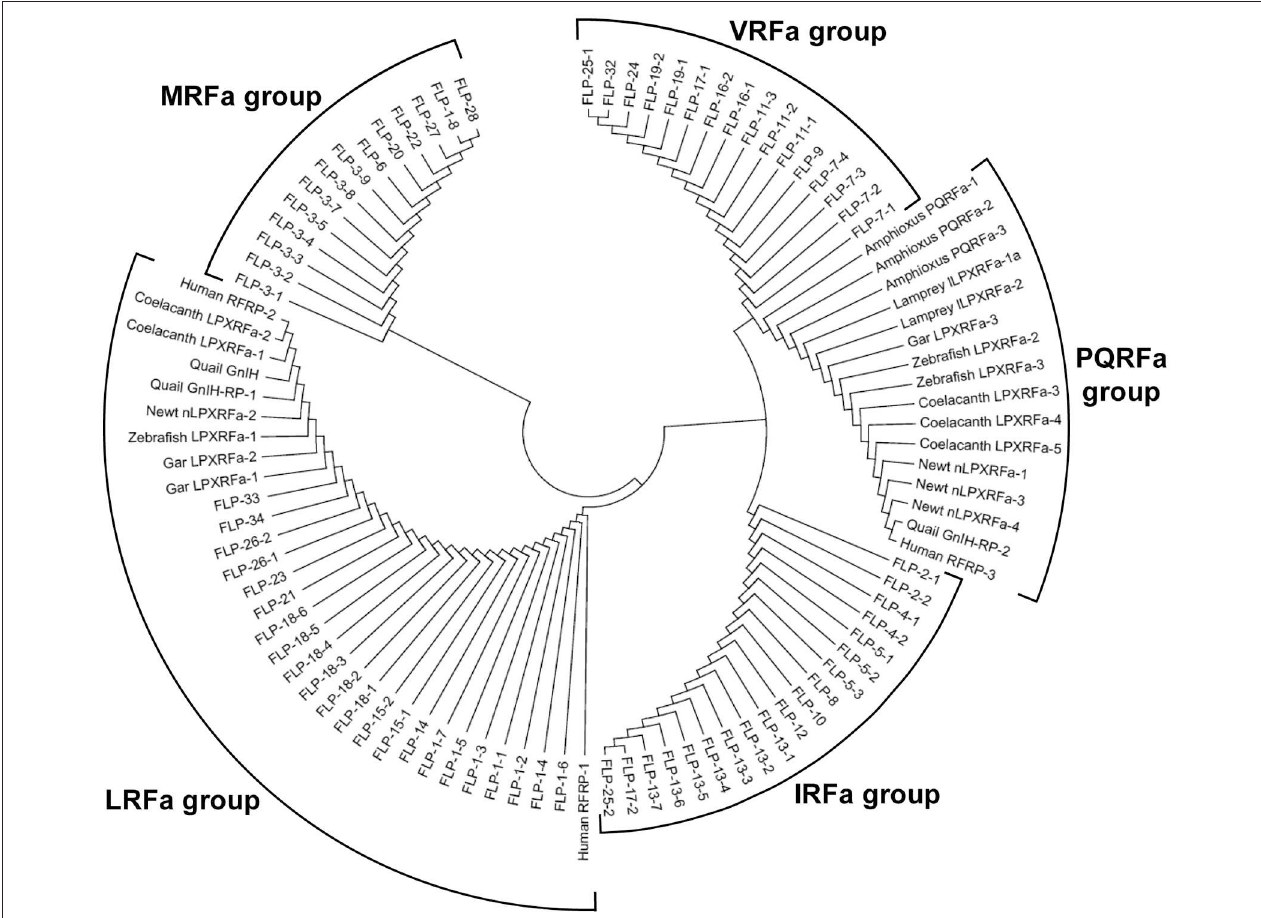
FIGURE 4 | A phylogenetic analysis of human, quail, newt, coelacanth, zebrafish, gar, lamprey, and amphioxus GnIH (LPXRFa) peptides and C. elegans FMRFamide-like peptides (FLPs). Predicted or biochemically identified endogenous peptides shown in Table 3 were analyzed. The accession numbers of their precursor proteins are shown in the legend of Figure 1 . The phylogenetic tree was constructed by Neighbor Joining method (Saitou and Nei, 1987) with the proportion of different sites statistical substitution model using MEGA 7 (Kumar et al., 2016).